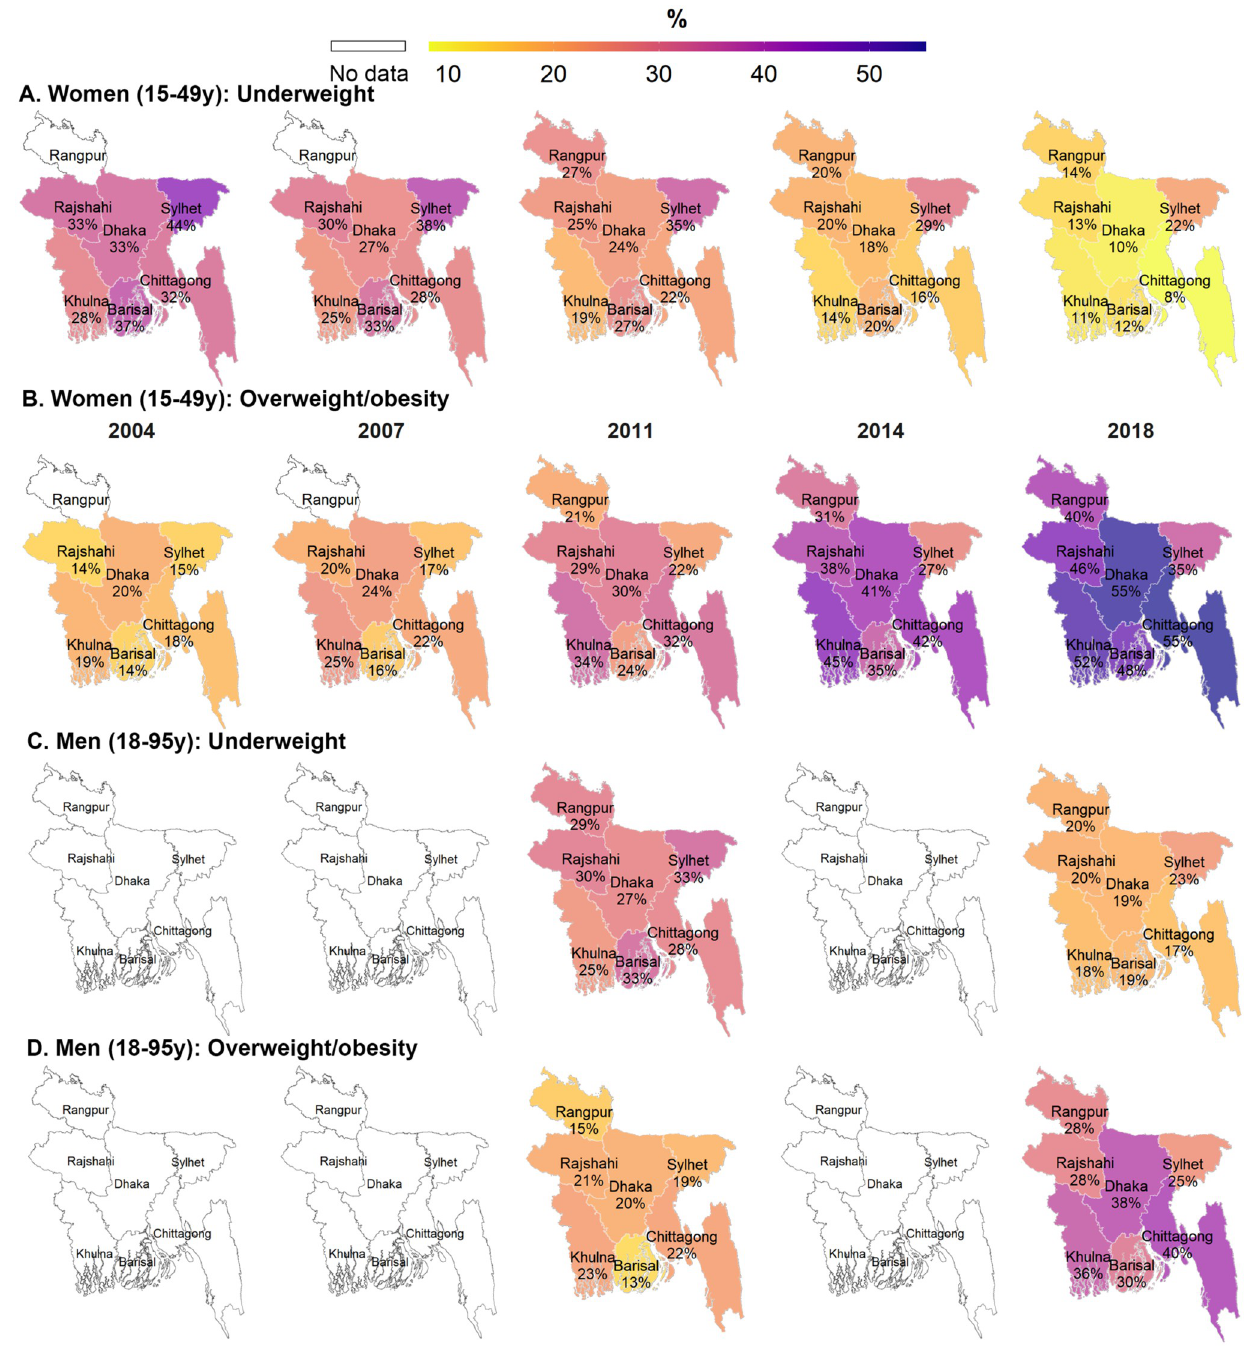
Fig 3. Prevalance of underweight and overweight/obesity among women and men by division and survey round, Bangladesh 2004–2018. (A) Women (15-49y): Underweight. (B) Women (15-49y): Overweight/obesity. (C) Men (18-95y): Underweight. (D) Men (18-95y): Overweight/obesity. Note: This map is created from the shapefile (an empty map) that is publicly available from http://gadm.org.